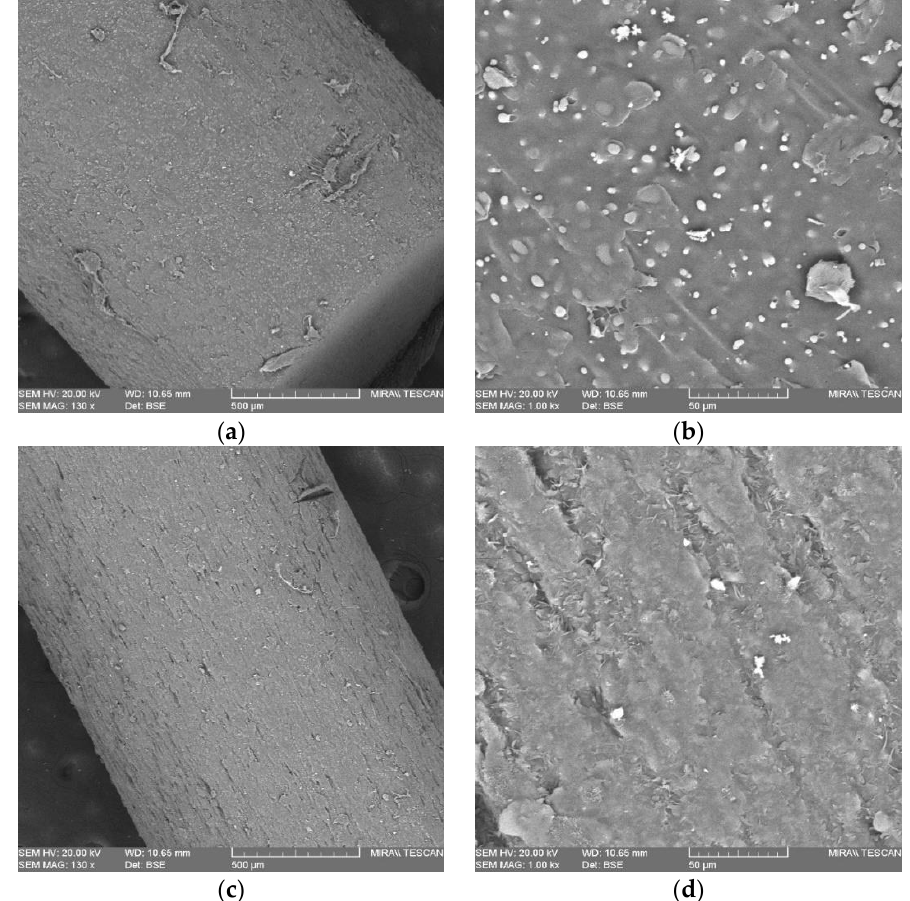
Figure 5. SEM scans of surface morphology of the filament: ( a ) placebo 130×; ( b ) placebo 1000×; ( c ) drug-loaded 130×; ( d ) drug-loaded 1000×.